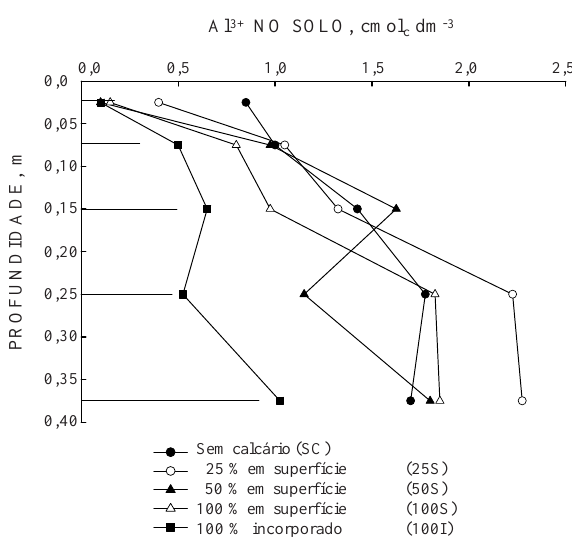
Figura 2. Teores de Al 3+ em cinco camadas do Argissolo Vermelho distrófico arênico cultivado com milho sob semeadura direta. Barras horizontais representam o